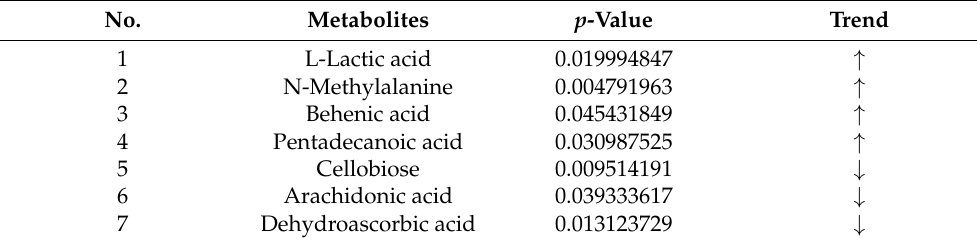
Table 6. Regulation of metabolites by ZZX-ACG in the hippocampus of anxiety rats. No. Metabolites p -Value Trend 1 L-Lactic acid 0.019994847 ↑ 2 N-Methylalanine 0.004791963 ↑ 3 Behenic acid 0.045431849 ↑ 4 Pentadecanoic acid 0.030987525 ↑ 5 Cellobiose 0.009514191 6 Arachidonic acid 0.039333617 Dehydroascorbic